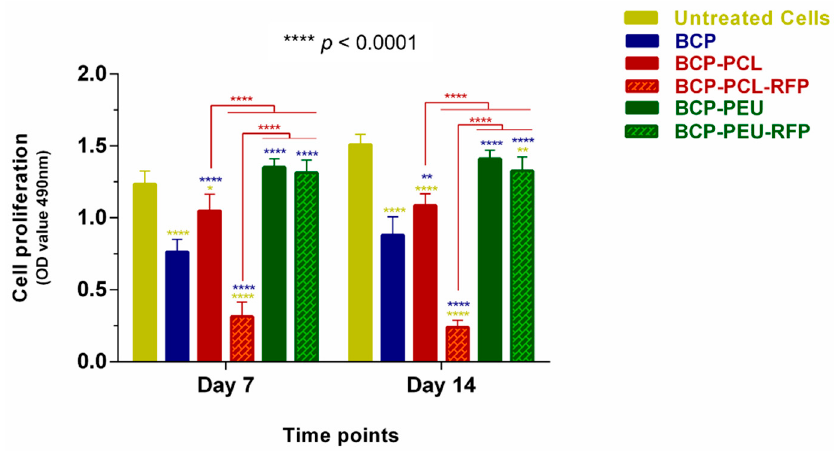
Figure 7. MTS assay for the proliferation of human mesenchymal stem cells (hMSCs) on the scaffolds cultured under different conditions on day 7 and 14. * p < 0.05; ** p = 0.0026, **** p <